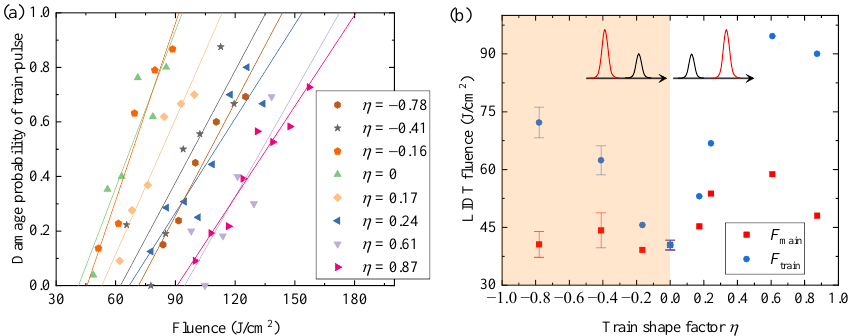
Figure 3. ( a ) Relations between damage probability and laser fluence of pulse trains with different shape factors η at the 20 ns delay. ( b ) Dependence of dual-pulse train threshold F train and main-pulse threshold F main on the factor η at the 20 ns delay. Inset: Sketches of temporal shapes of dual-pulse train. For η < 0, the dual-pulse train has a ramp-down shape. By increasing the shape factor η from − 0.78 to 0, the train threshold F train decreases, but the main-pulse threshold F main is almost invariable and keeps the same to single-pulse threshold F single , which is ~40.4 J/cm 2 . It indicates that the post-pulse has little influence on the damage initiation and main-pulse damage threshold while the main pulse is responsible for the initiation of the damage